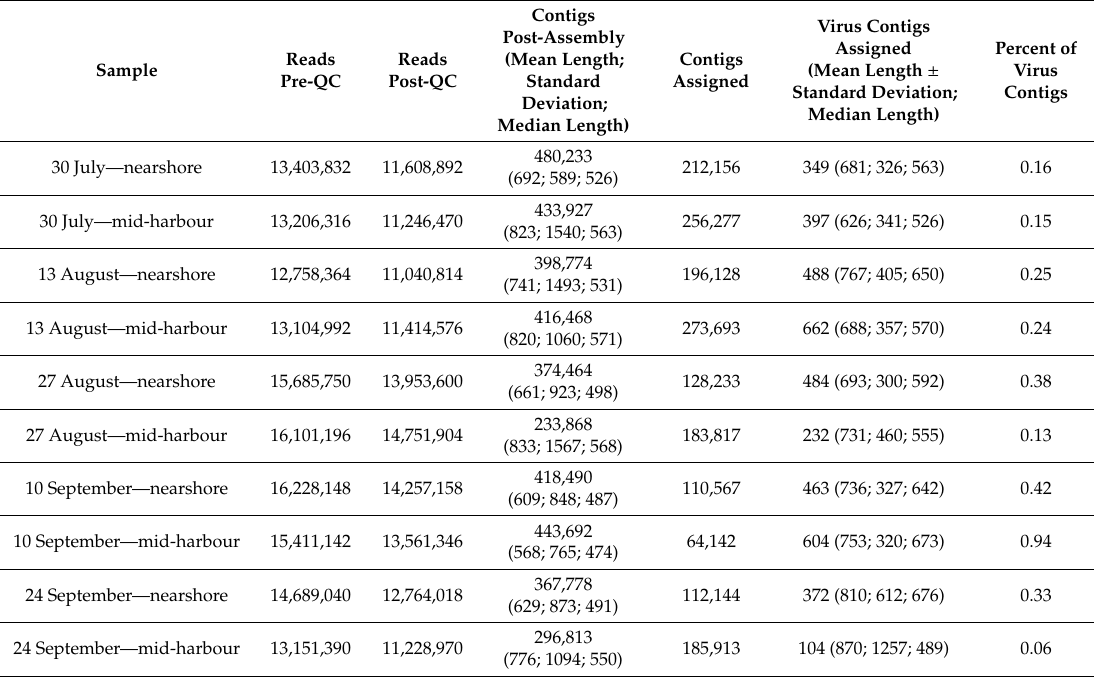
Table 2. Summary of the number of reads and contigs at each step in the data processing pipeline.